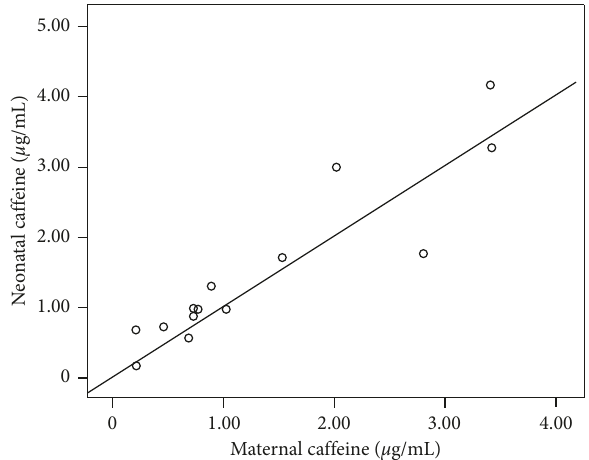
Figure 5: Linear regression between plasma caffeine concentra- tions in mother versus newborn